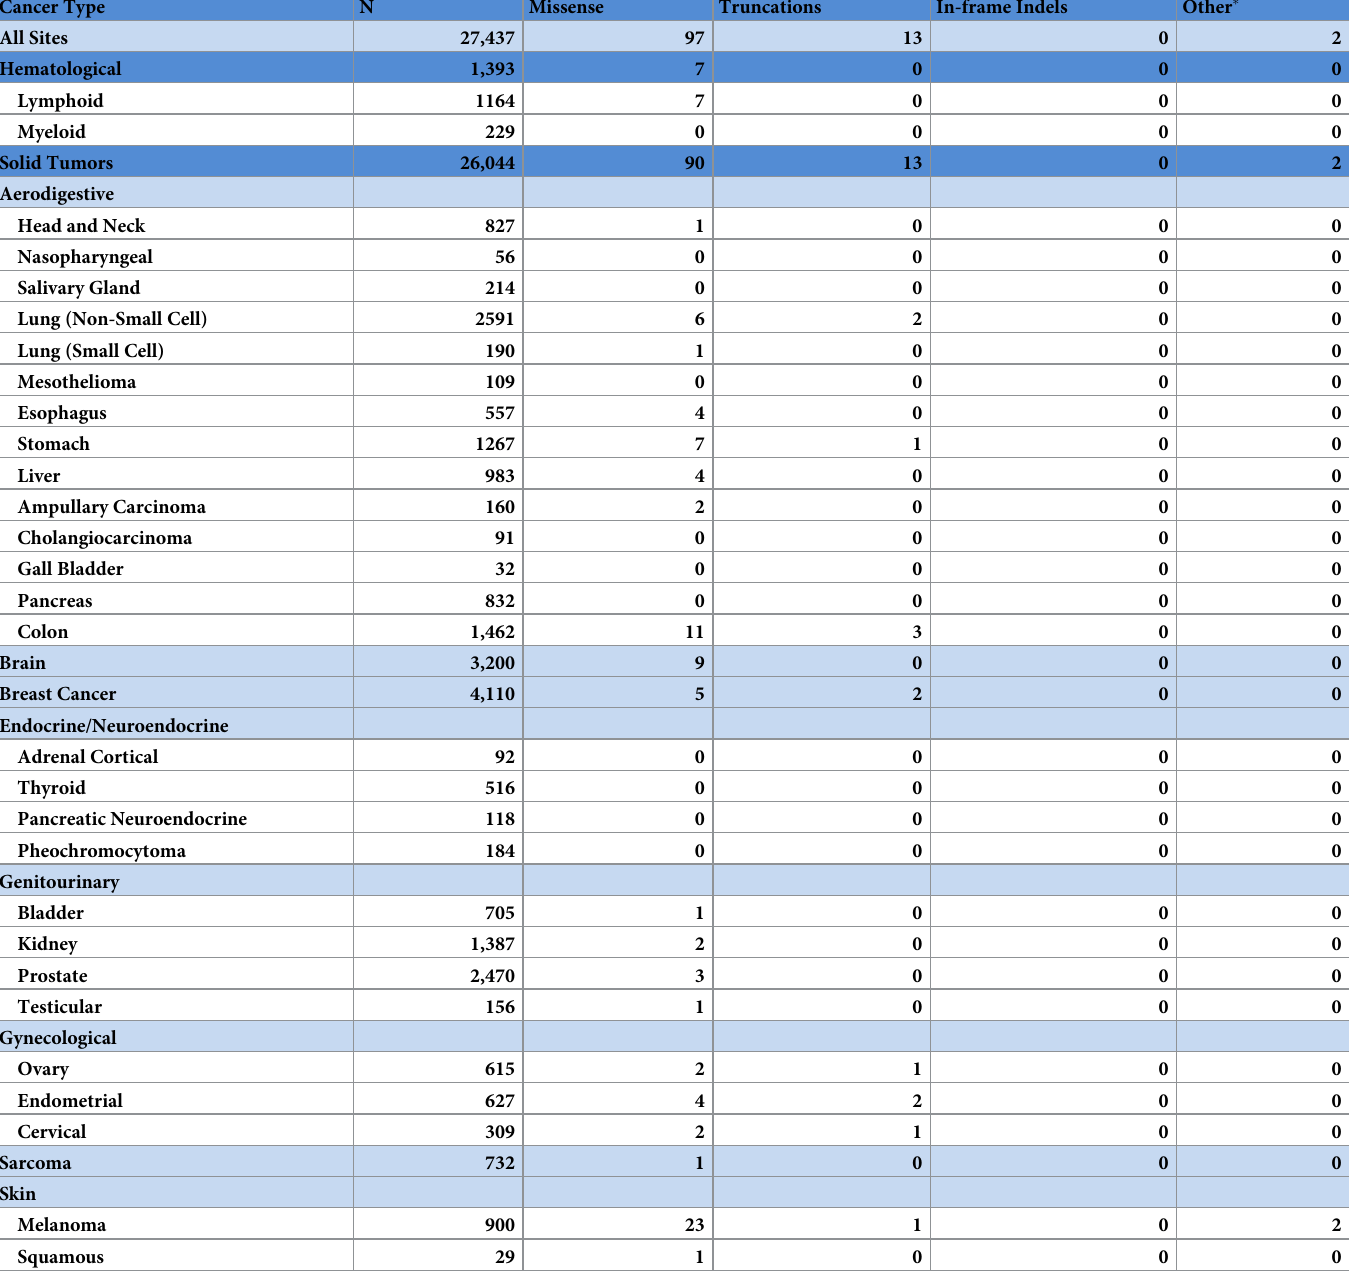
Table 1. Cbl-c mutations by tumor type in TCGA. Cbl-c mutations were identified in the cBioPortal for Cancer Genomics database as indicated in the table. Cancer Type